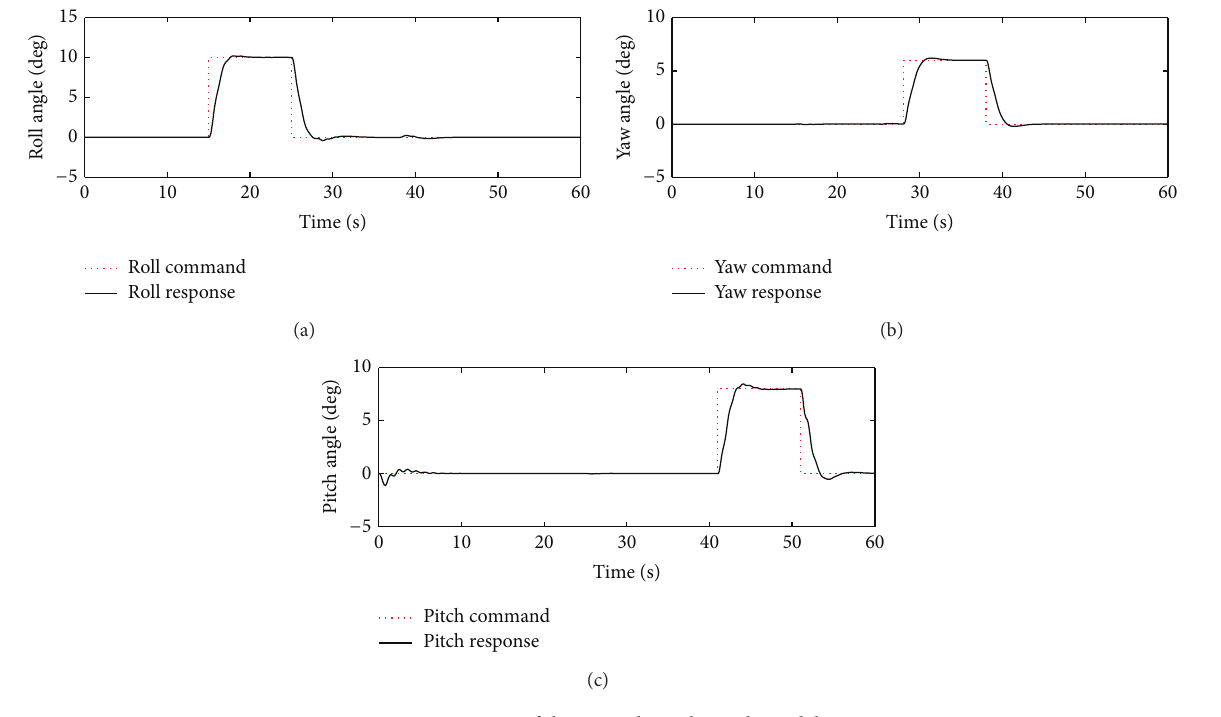
Figure 6: Responses of the Attitude angles with model error.